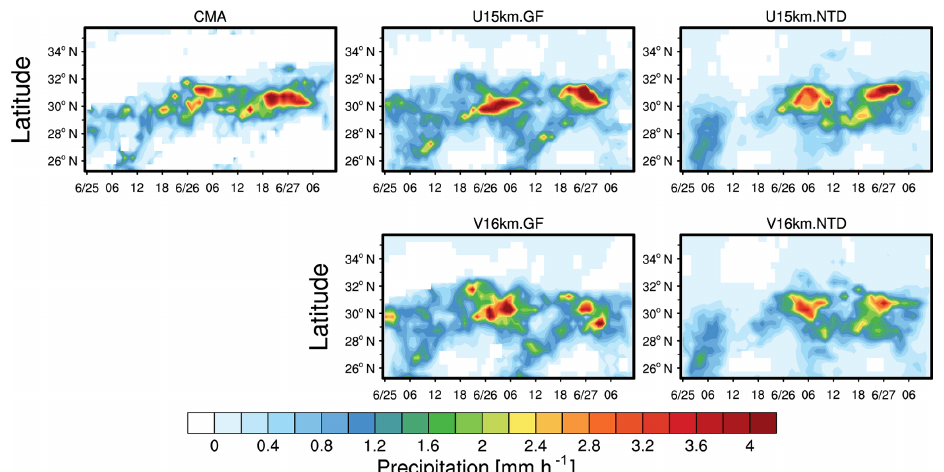
Figure 4. Time–latitude cross section of precipitation during the event averaged over East China (denoted as the black box in Fig. 2) from the CMA station observations and the simulations with global uniform and variable resolutions with two convective parameterizations. The modeling results are sampled at the CMA